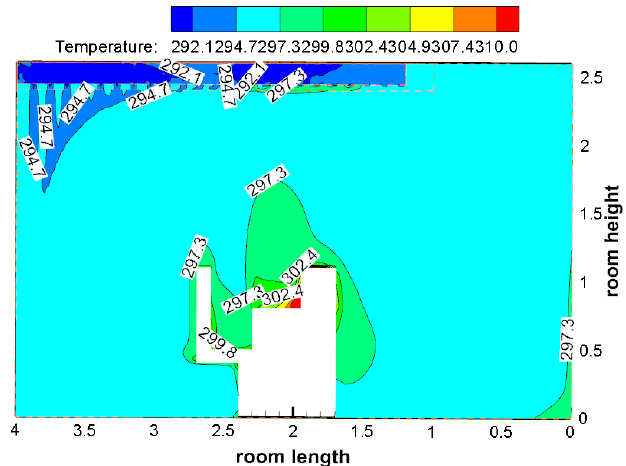
Figure 29. The temperature distribution of the Y = 0.6 m section.